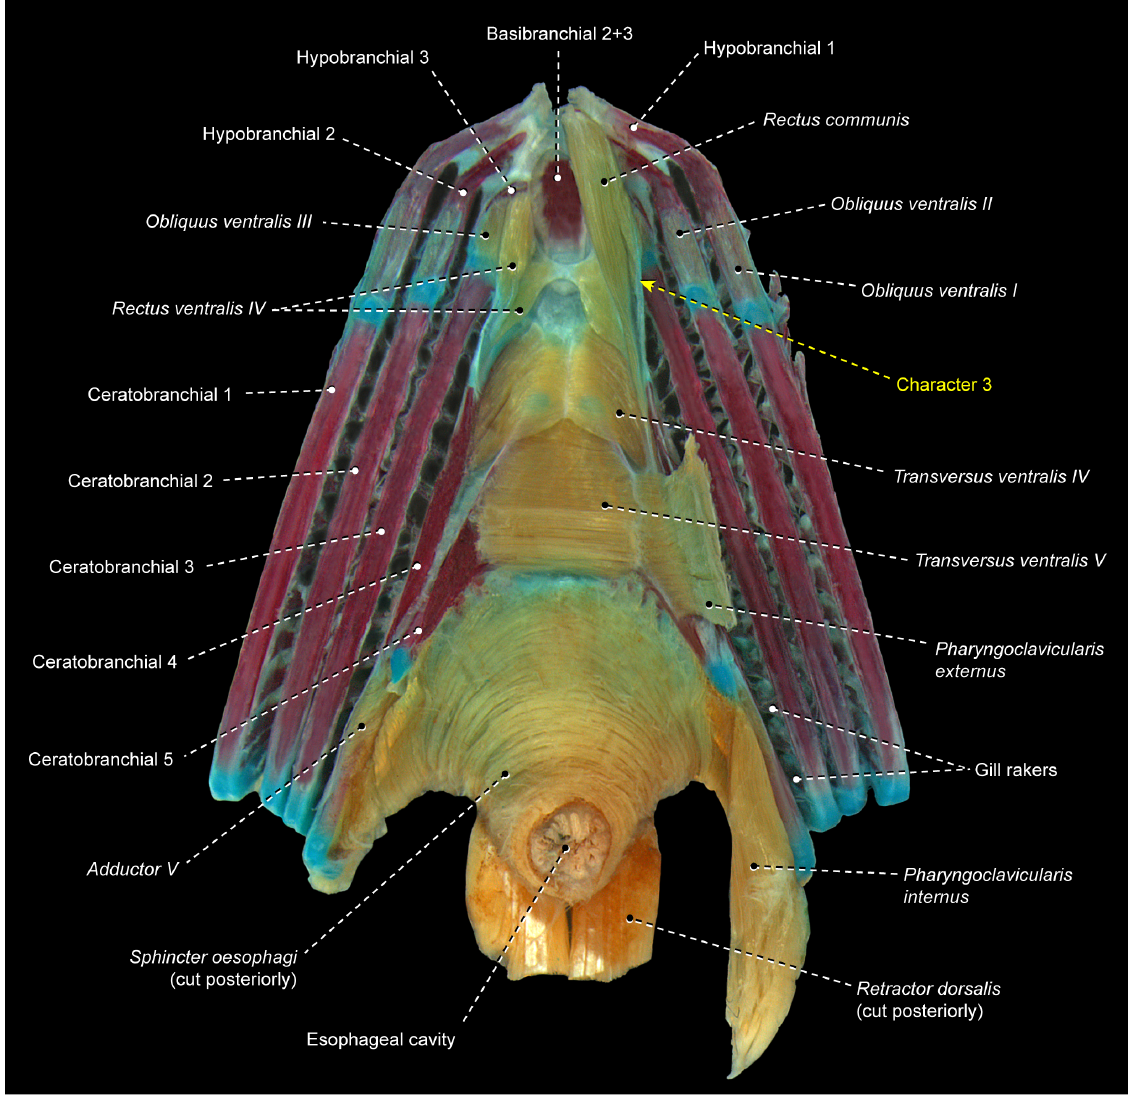
Figure 7. Branchial musculoskeletal system of Porichthysporosissimus (Batrachoidiformes: Batrachoididae). MZUSP 46971. Ventral view; right pharyngoclavicularis externus , pharyngoclavicularis internus and rectus communis removed.